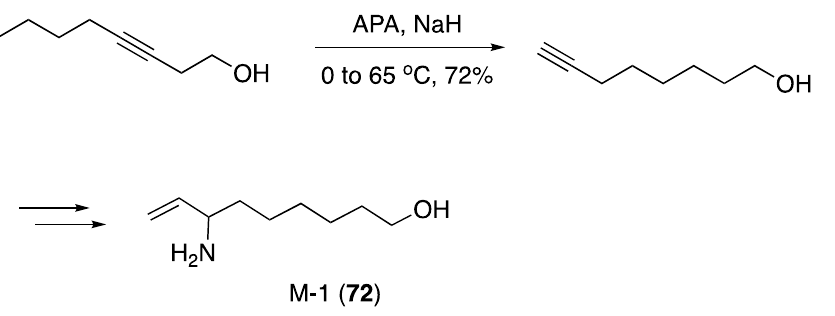
Figure 8. The structures of different classes that have all prepared with the alkyne zipper reaction as part of the synthesis.